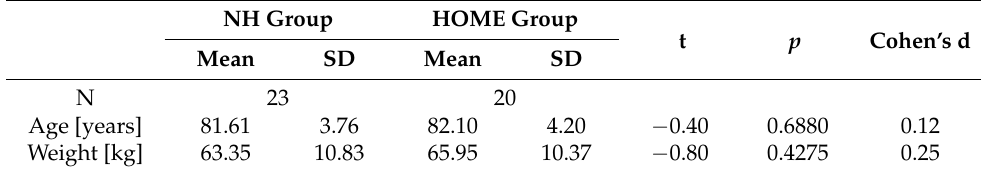
Table 1. Characteristics of the studied groups.